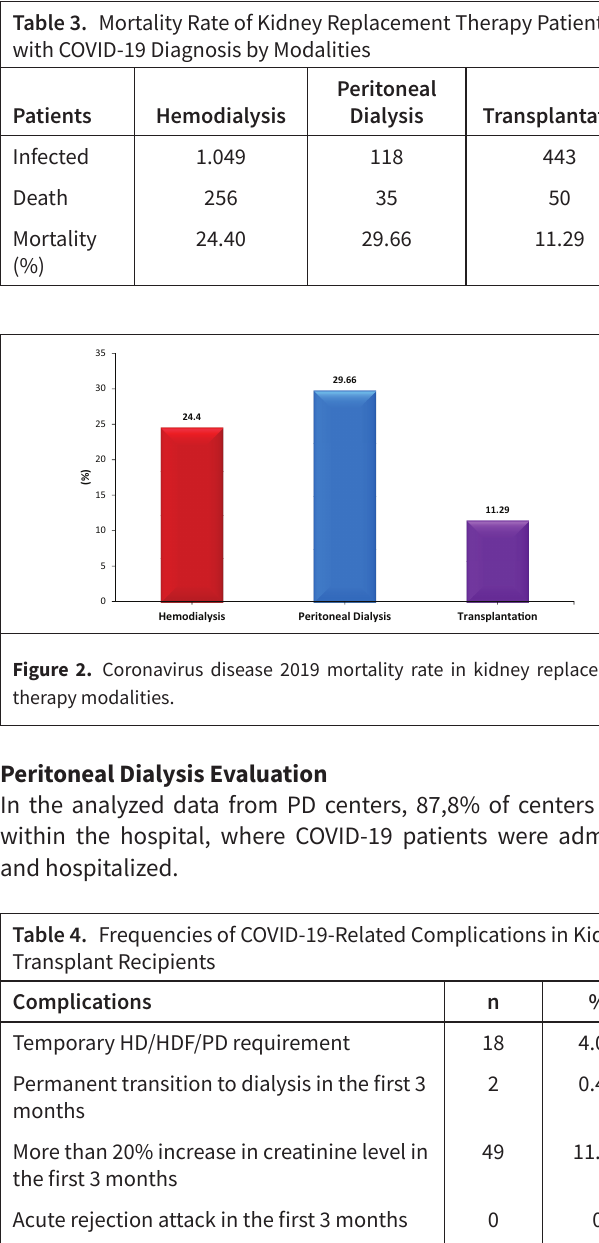
COVID-19 Diagnostic Method